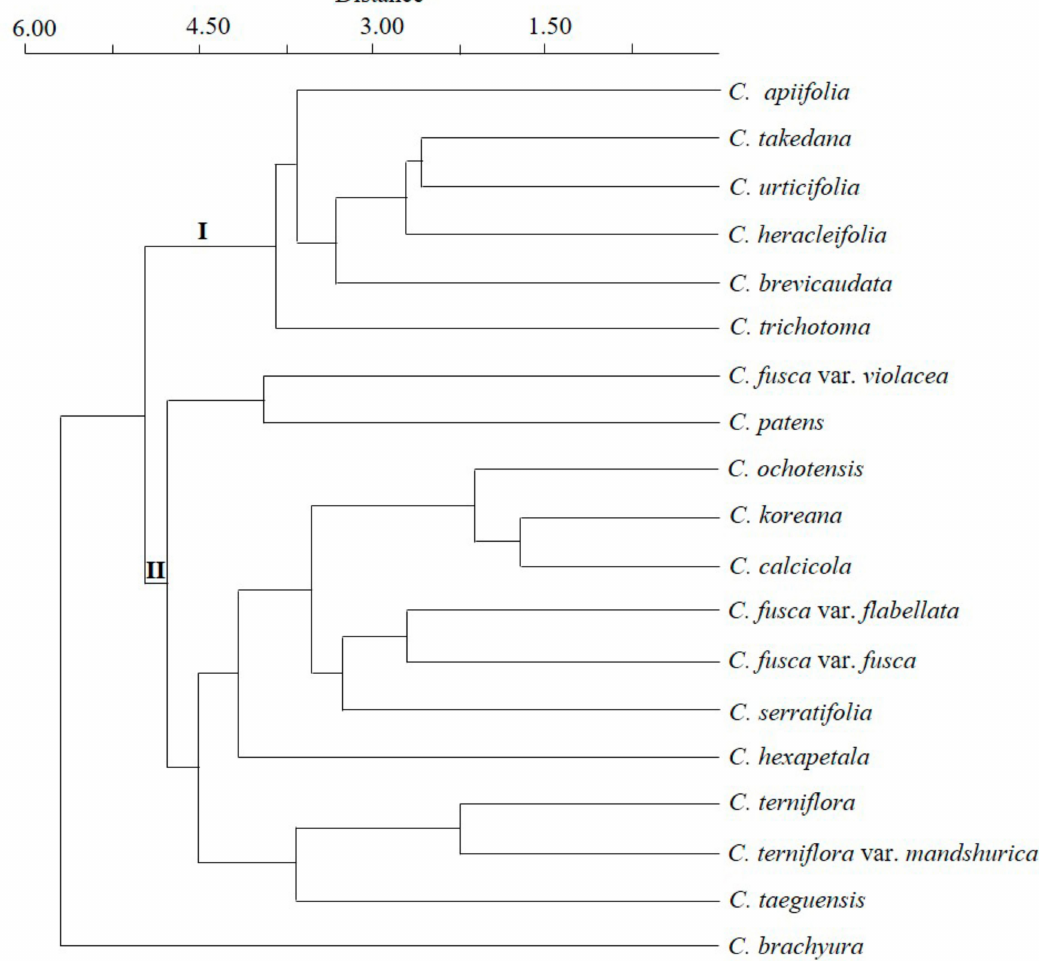
Figure 10. UPGMA cluster analysis based on achene characters of Clematis